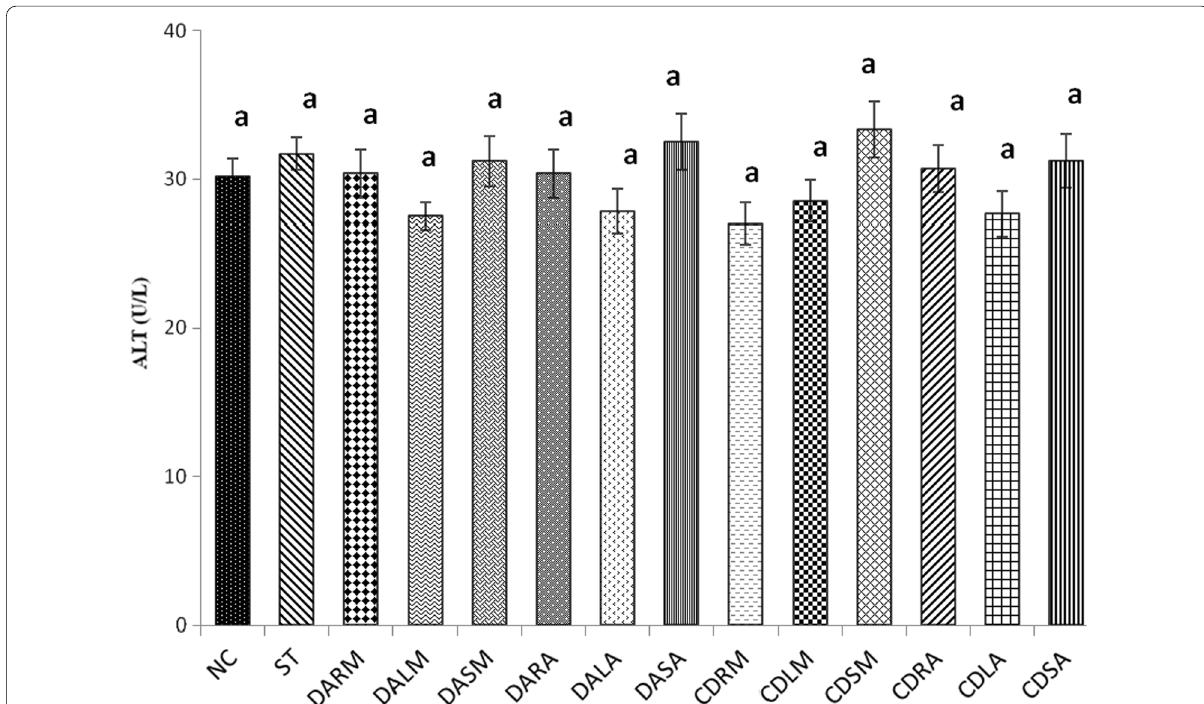
Fig. 10 Effects of administration of methanolic and aqueous extracts of roots, leaves and stem of D. arborescens and C. dependens on Alanine transaminase (ALT) of rats. Bars with similar alphabets are not statistically different ( p < 0.05)